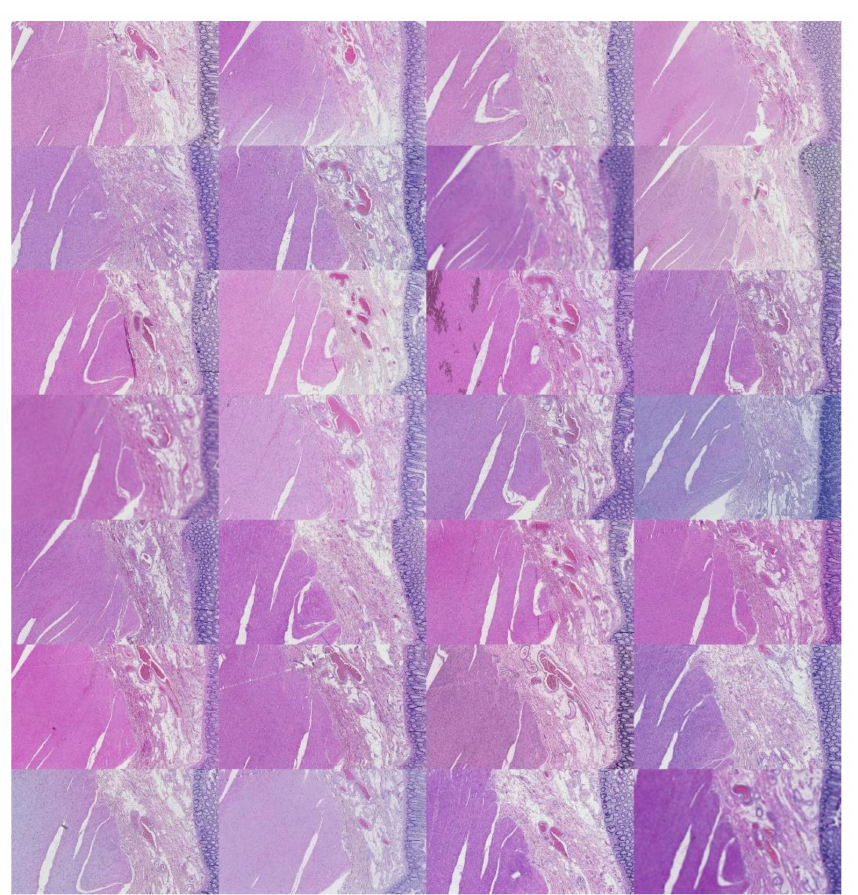
Figure A10. Colon examples visualized by descending silhouette score within the second found cluster (C2). Silhouette values descend in the left direction from the left-most example in the first